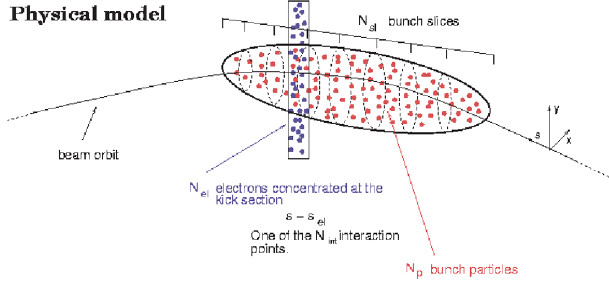
FIG. 38. (Color) Evolution of the LHC vertical beam size at injection with turn number simulated by the code PEHTS for an electron density of 1 (cid:1) 10 11 m (cid:2) 3 [88]; the curves correspond to different synchrotron tunes as